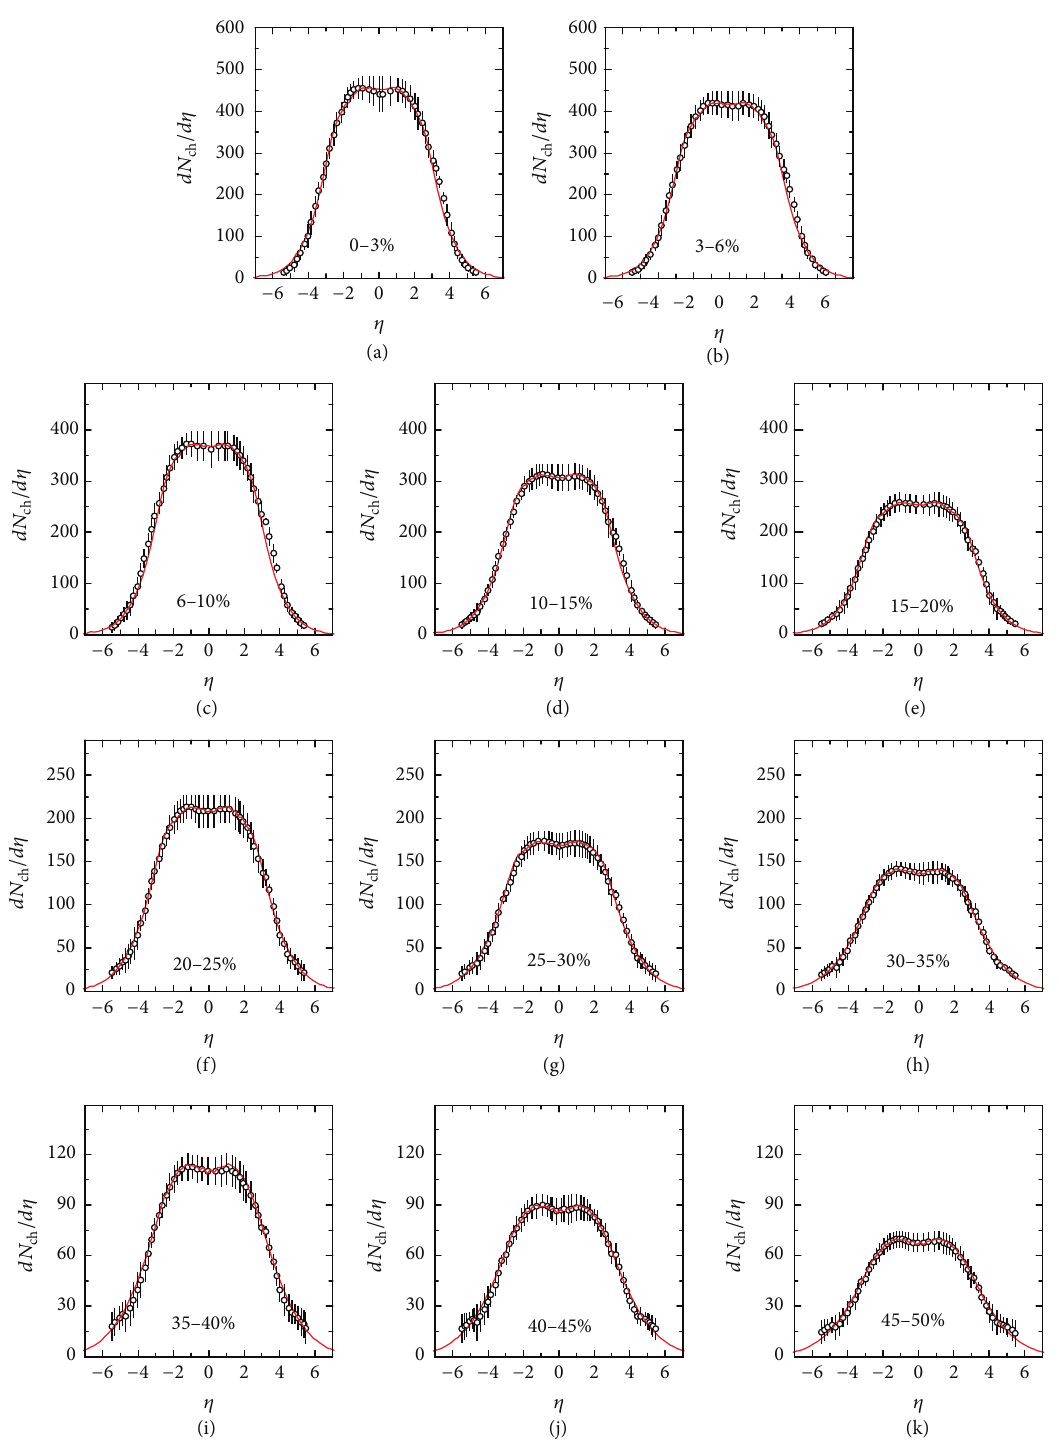
Figure 2: The same as Figure 1 but showing the results of Au-Au collisions at √𝑠 NN = 62.4 GeV.